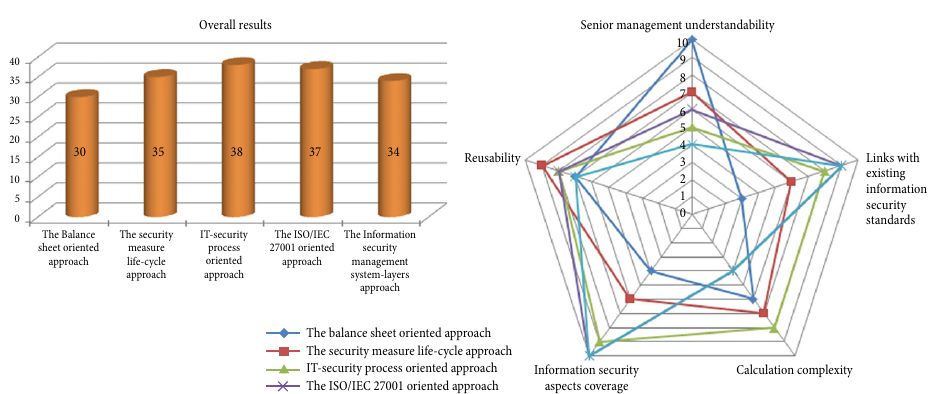
Fig. 1. Information security costs implementation methods comparison results